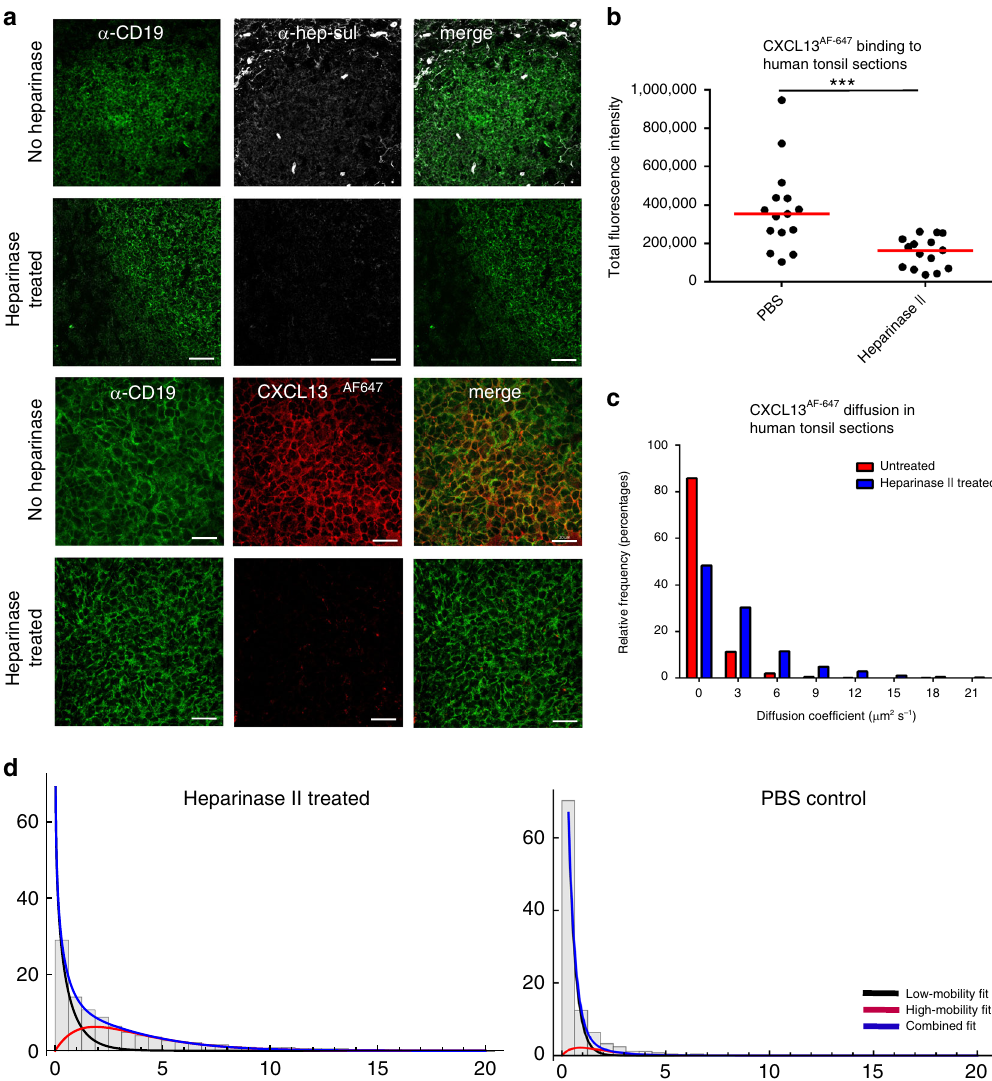
Fig. 3 CXCL13 interactions with ECM components constrain mobility. a Tonsil tissue sections were stained with anti-CD19 and anti-heparan sulfate antibodies. Following incubation in PBS or heparinase II treatment binding of CXCL13 AF647 to the B follicle was assessed. b Quanti fi cation of total fl uorescent intensity for each image. Shapiro − Wilk tests indicated that the datasets were not normally distributed ( p value< 0.001) and so signi fi cance was assessed using a Mann − Whitney U test ( p value< 0.001; ***). Data shown are from a single experiment (from a total of two independent experiments) with each data point representing a distinct follicle obtained from a single patient. c Quanti fi cation of CXCL13 AF647 mobility in CD19 + -positive regions of human tonsil sections. Diffusion measured in untreated tissue sections is indicated in red with values obtained for heparinase II-treated sections indicated in blue. All tissue sections were obtained from the same patient. The median [IQR] diffusion rate of CXCL13 AF647 in untreated sections was calculated as 0.19 [0.001 − 0.79] μ m 2 s − 1 , while treatment with heparinase-II led to a signi fi cantly different (assessed using the Mann − Whitney U test) diffusion coef fi cient of 1.6 [0.47 − 3.9] μ m 2 s − 1 ( p < 0.0001). d Characterizing the multiple modes of diffusion observed in our single-molecule tracking analysis in B-follicles